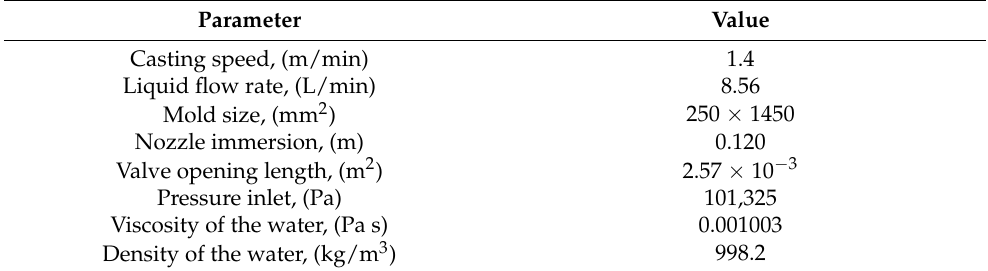
Table 1. Physical properties and experimental conditions, using nozzles A and